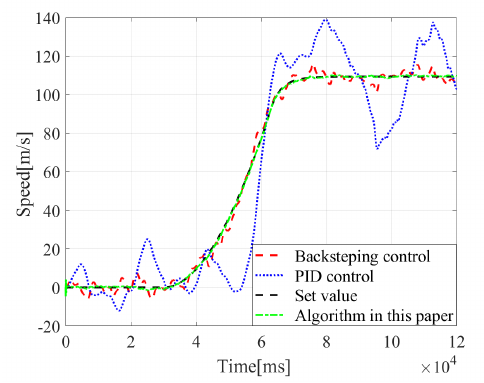
Fig. 7. Velocity curve in vertical direction in transition phase.